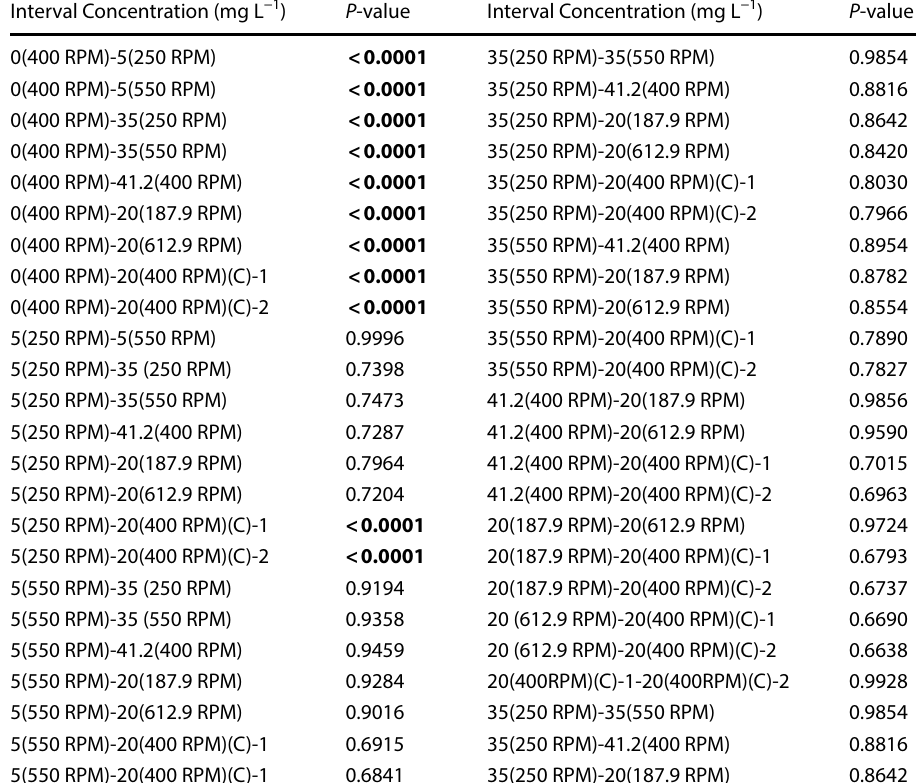
Table 3 t-test assuming different variances for the Tanfloc SG® coagulant in the main treatments (α =